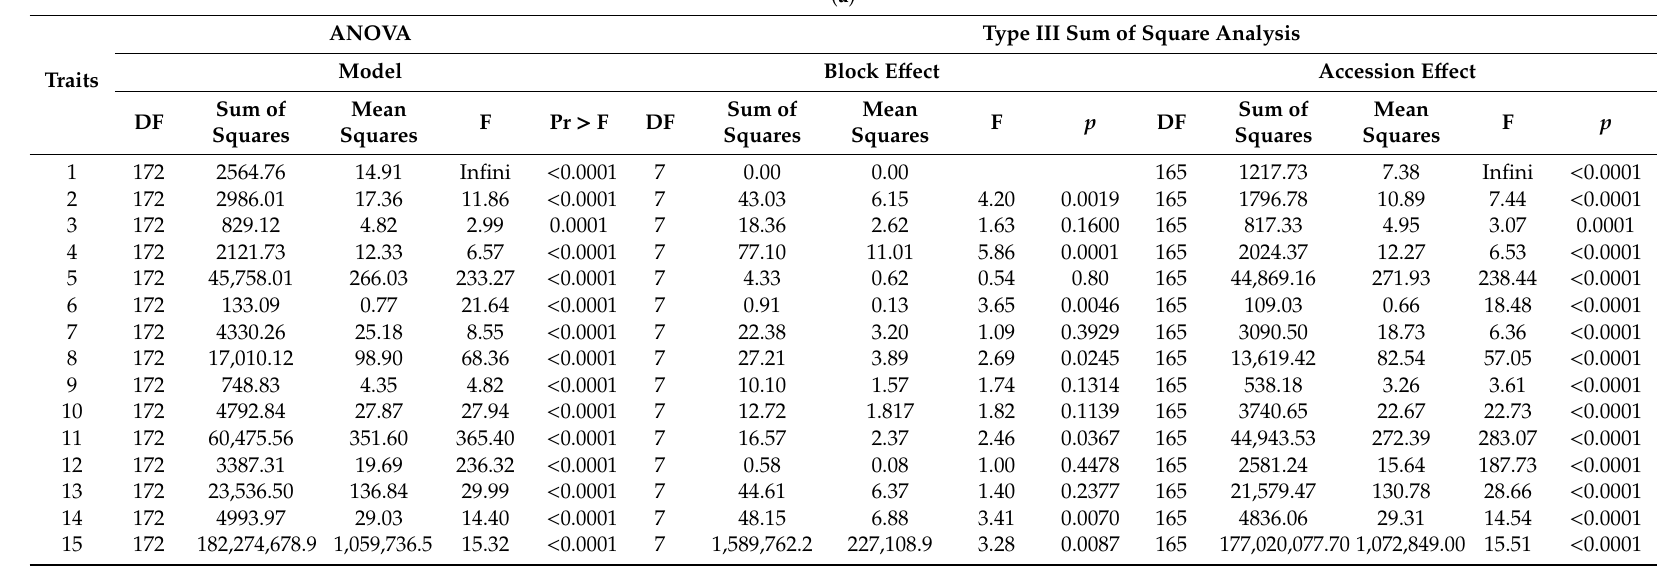
Table 3. ( a ) Analysis of variance (ANOVA) and type III sum of squares analysis for the selected quantitative traits* at the Tanzania Co ff ee Research Institute (TaCRI, Kilimanjaro region) during the 2018 cropping season; ( b ) analysis of the di ff erences and interactions between accessions and checks for the selected traits (all species) at the Tanzania Co ff ee Research Institute (TaCRI, Kilimanjaro region) during the 2018 cropping season. ( a )